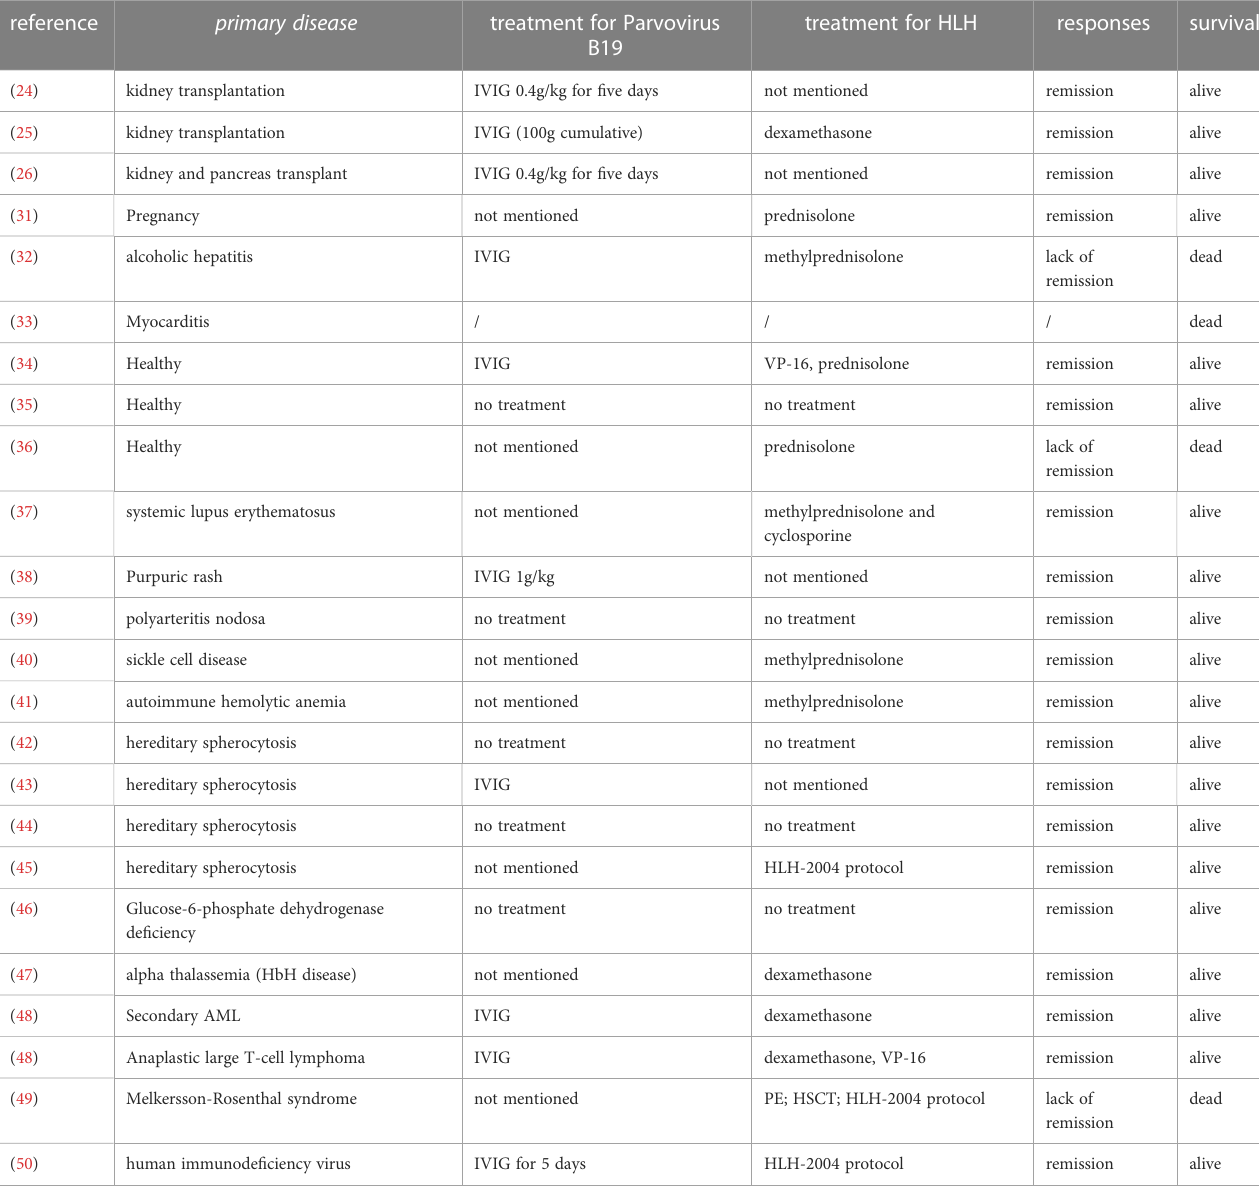
TABLE 1 Reported cases of Parvovirus B19 infection complicated by